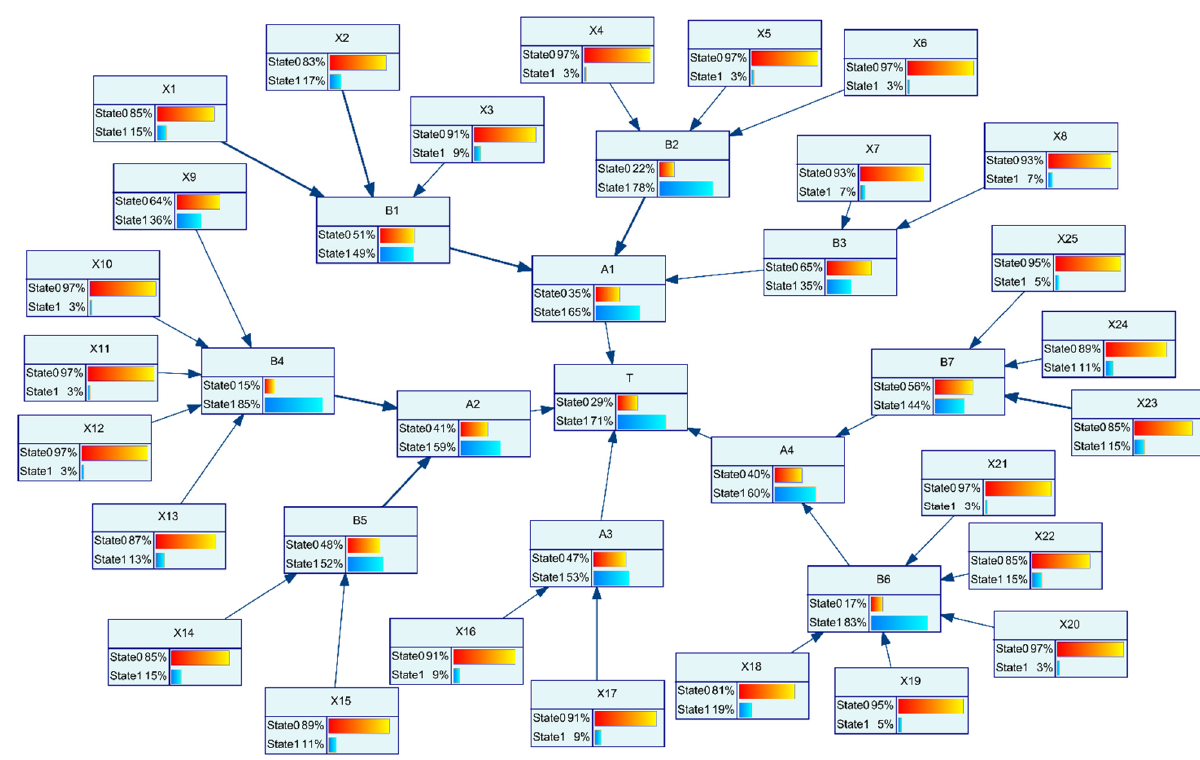
Figure 7. Results of accident causal chain analysis on BFG leakage.